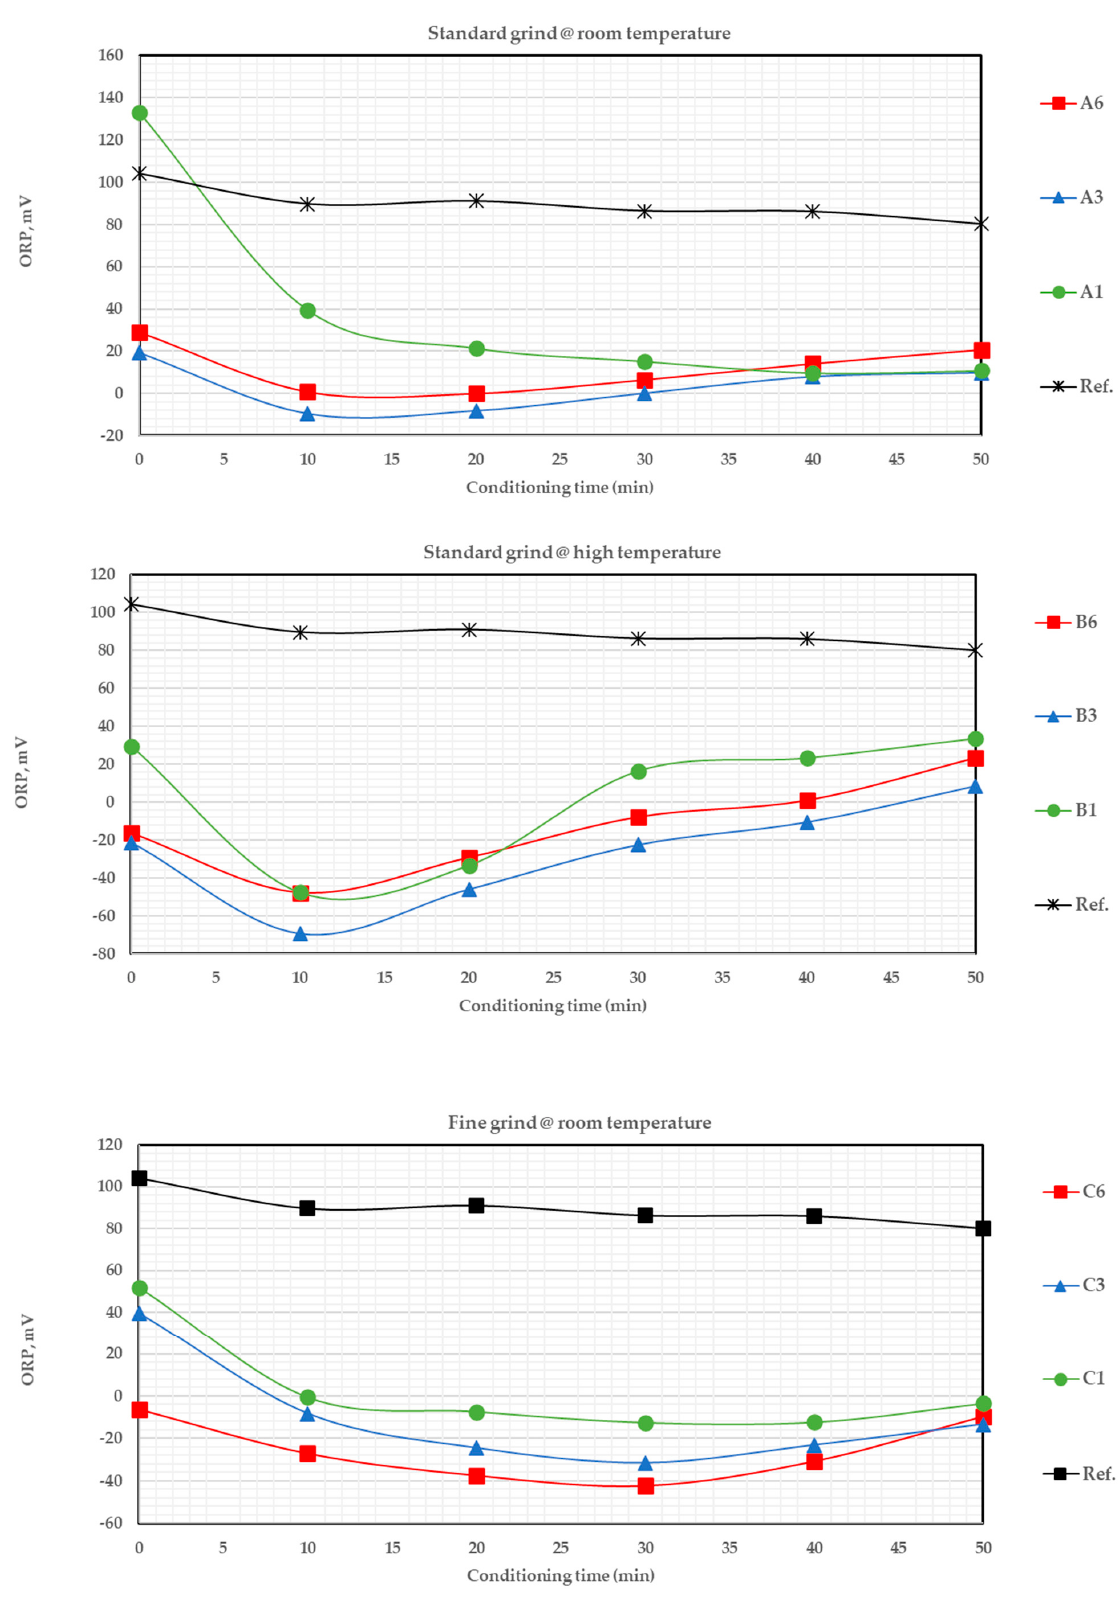
Figure 4. Effect of dissolution loop and dissolution time on ORP.